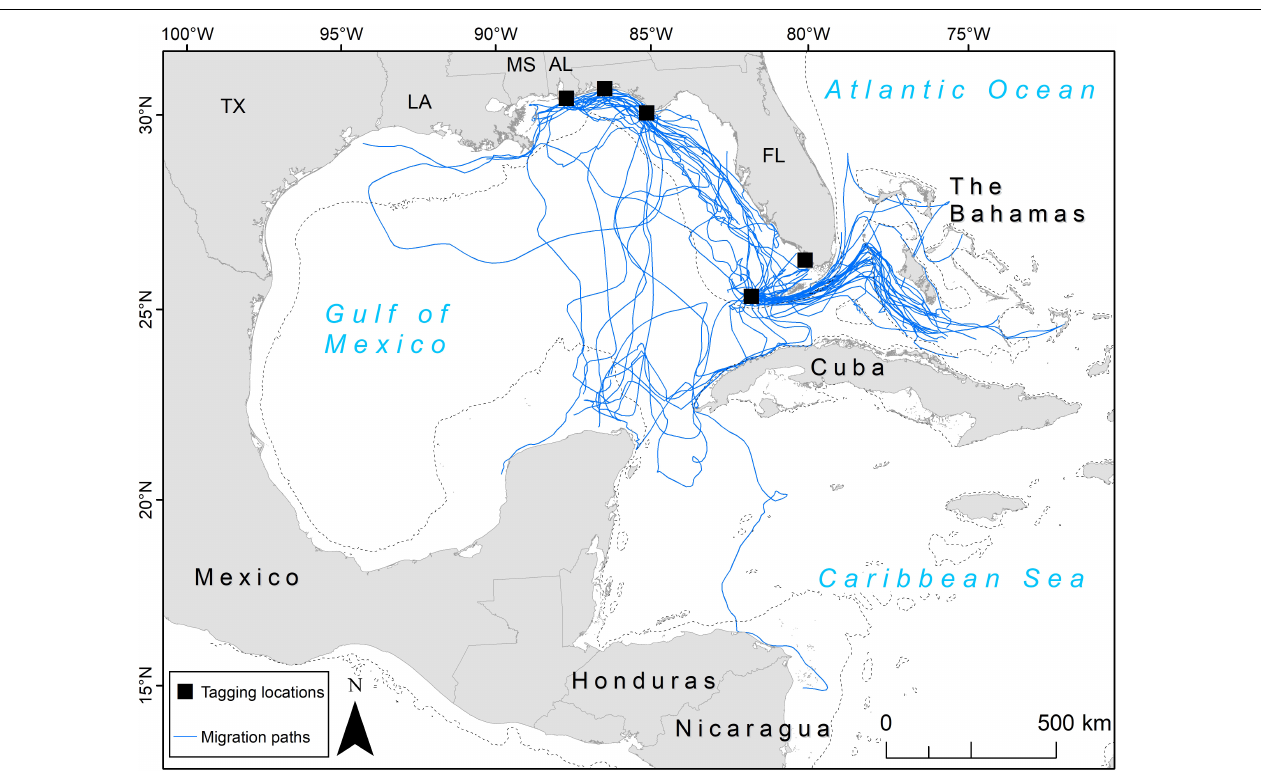
FIGURE 1 | Migration paths (blue lines) taken by 81 adult female loggerhead sea turtles ( Caretta caretta ; 89 tracks) after being tagged at nesting beaches throughout the Gulf of Mexico. Tagging locations (black squares) from top left moving clockwise: Gulf Shores, Eglin Air Force Base, St. Joseph Peninsula, Everglades National Park, Dry Tortugas National Park. U.S. states are abbreviated: TX, Texas; LA, Louisiana; MS, Mississippi; AL, Alabama; FL, Florida. The 200 m bathymetric contour is shown as a dashed